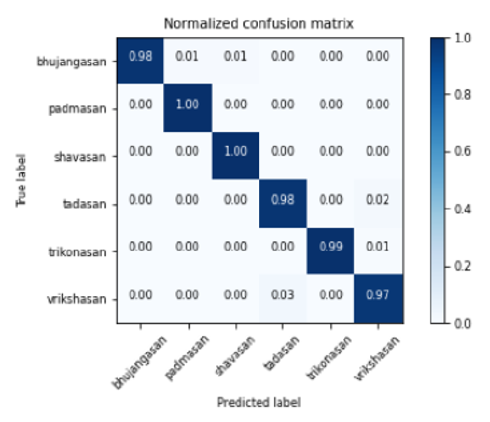
Figure 6. Confusion